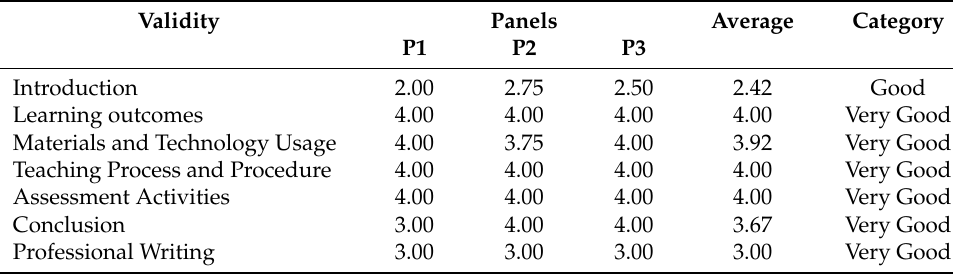
Table 1. This is a table of module and SDLP evaluation by experts based on the aspects of suitability and